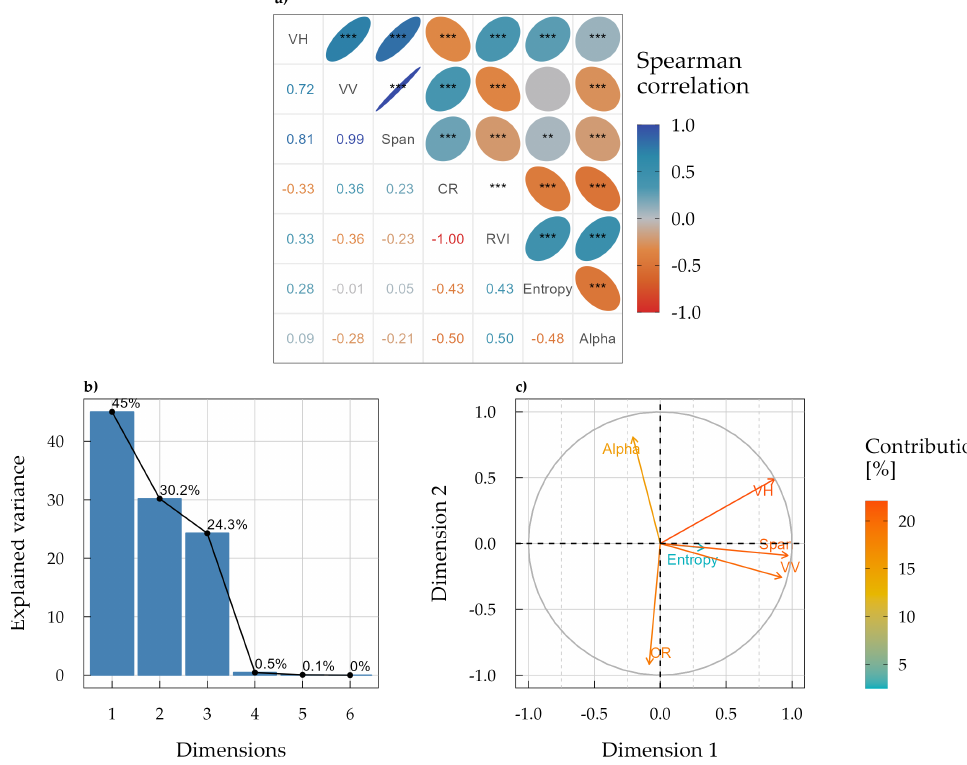
Figure 8. ( a ) Spearman-rank coefficients of S-1 dual-polarimetric variables with significance levels ( p < 0.001 = *** , p < 0.01 = ** , p < 0.05 = * ). ( b ) Dimensions of the principal components analysis (PCA), ranked by their relative variance in the feature space, features were normalized prior to the analysis. ( c ) Contributions (eigenvalue/contribution) and directionality (eigenvector/angle) of either variable with the PCA. The color ramp represents their strength of